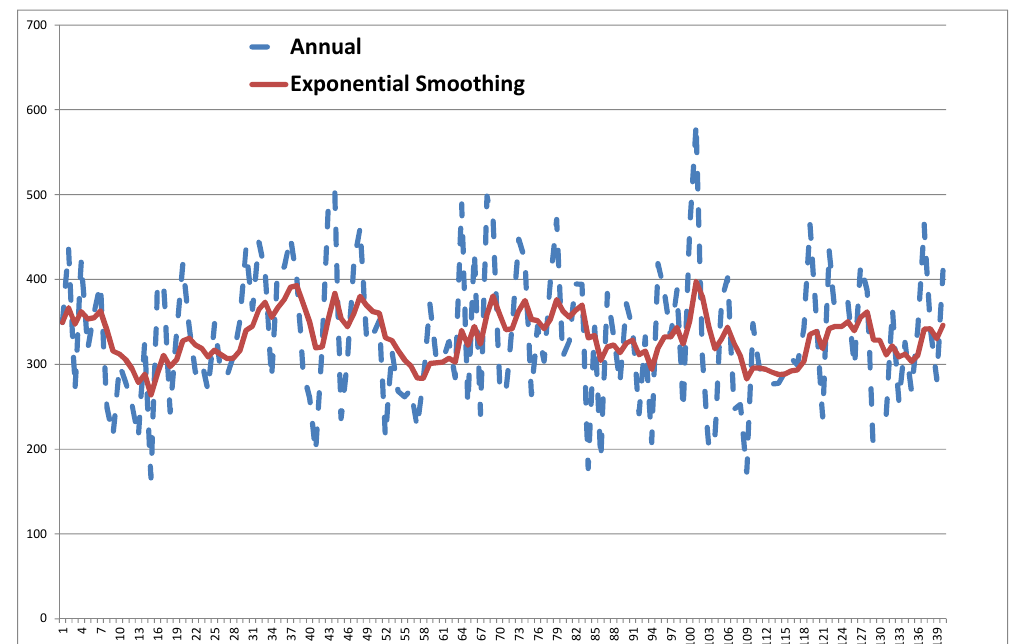
Figure 10. Annual rainfall totals for Port Wakefield, 34 . 18 ◦ S, 138 . 15 ◦ E, 1874–2013.